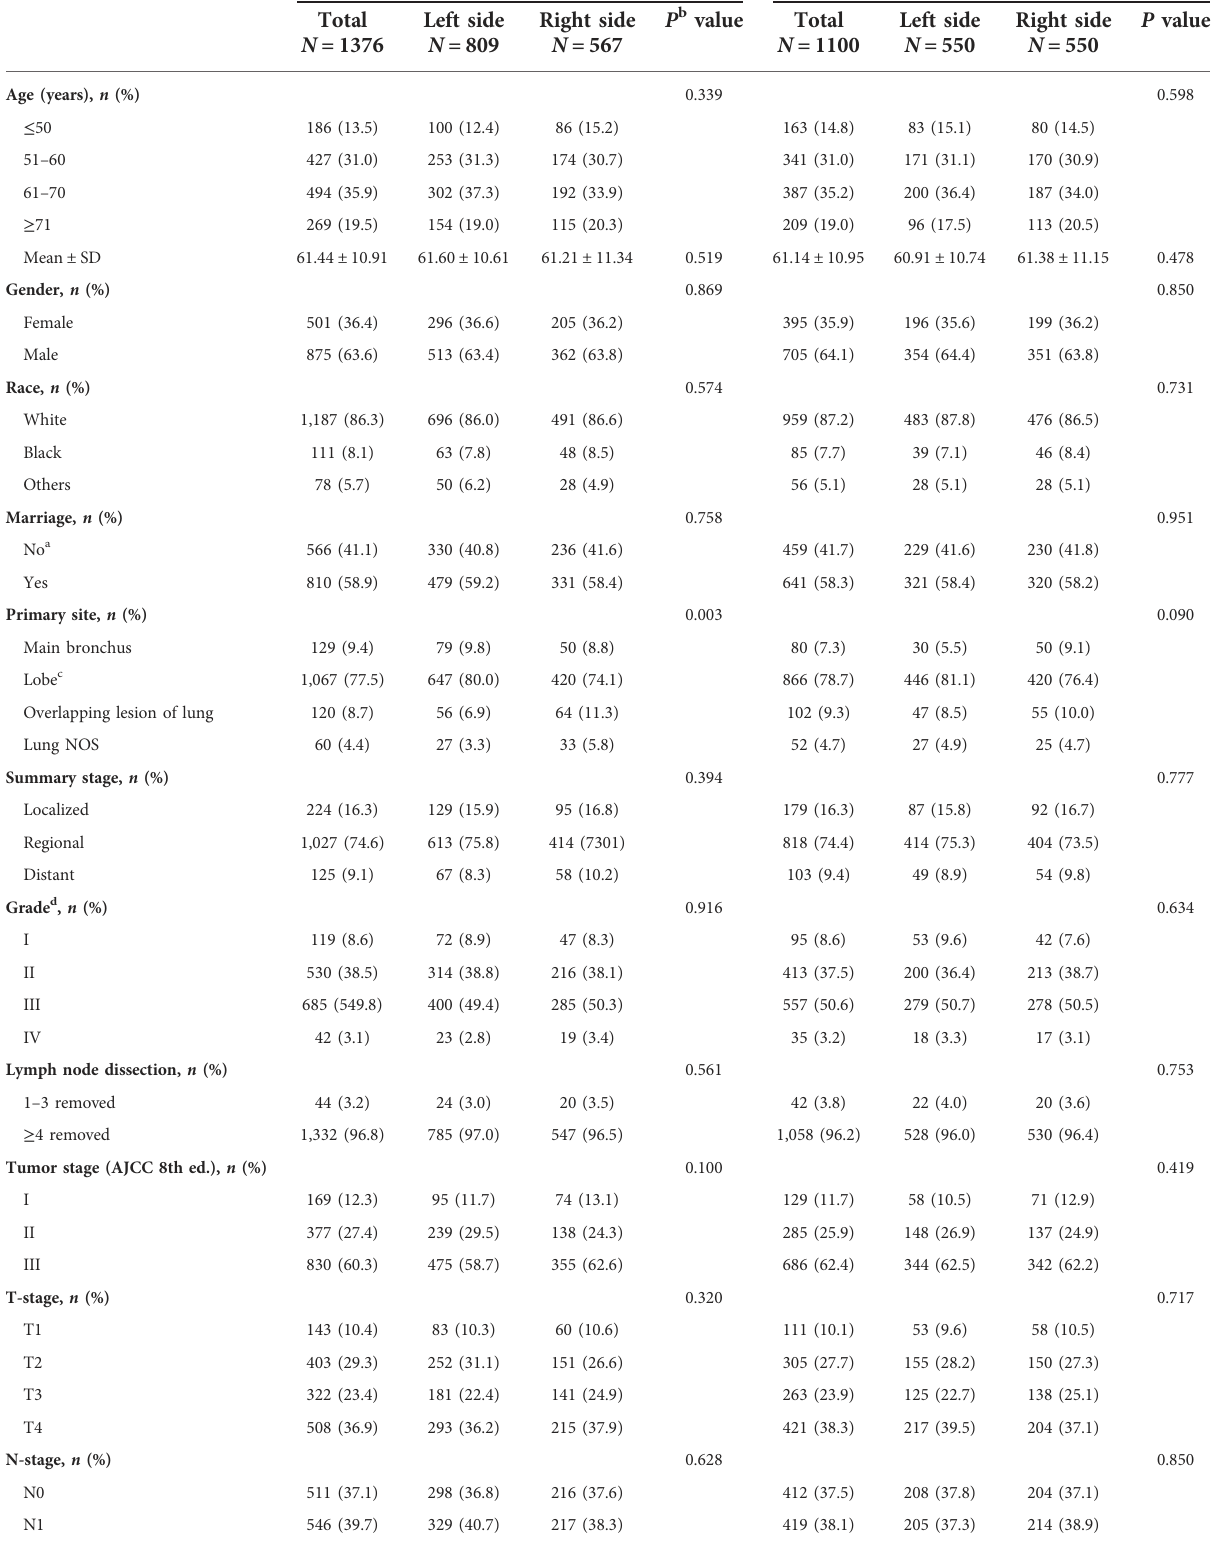
TABLE 1 Baseline patient characteristics before and after